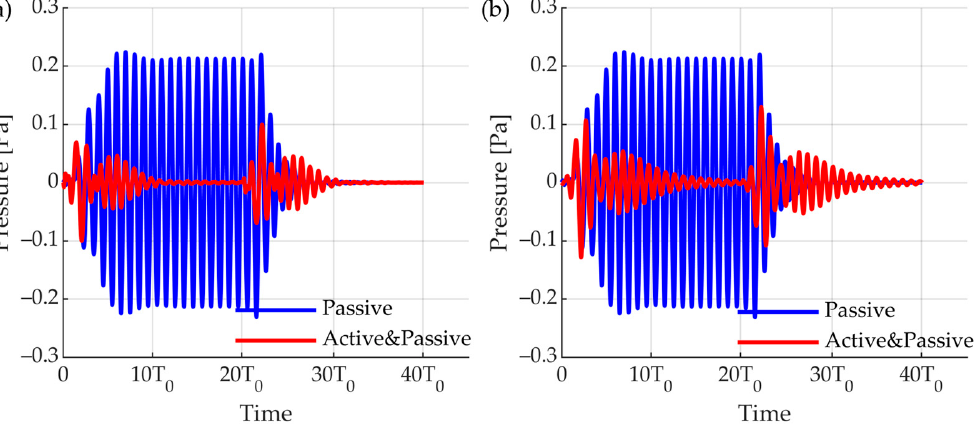
Figure 12. Cancellation effect of active reflection control feedback model. ( a ) Cymbal transducer; ( b ) stack PZT transducer.